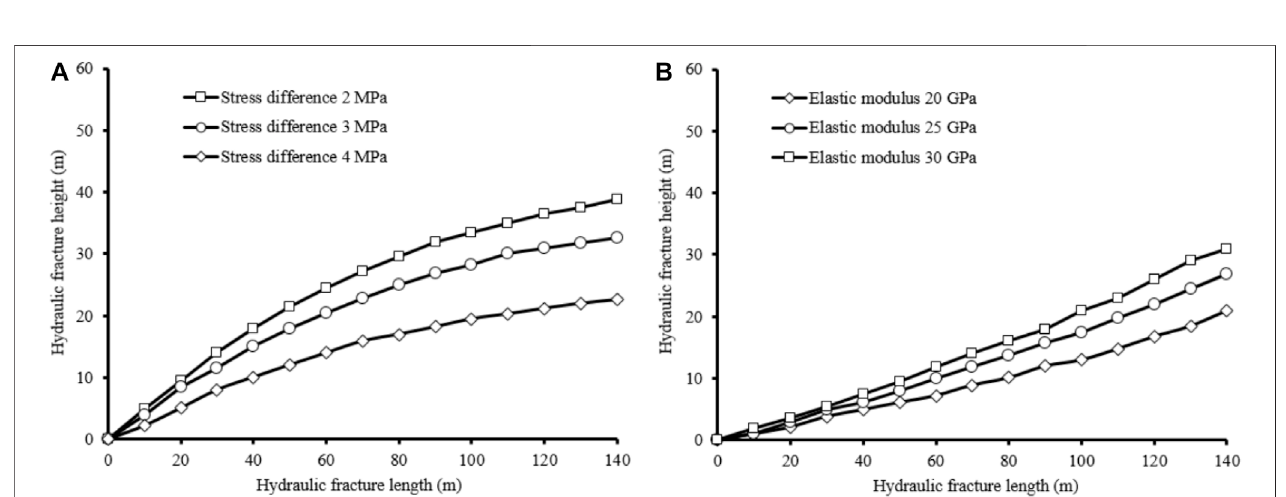
FIGURE 11 | In fl uence of in-situ stress and elastic modulus on hydraulic fracture height. (A) The in fl uence of the stress difference between the fracturing layer and the shielding layer on the hydraulic fracture height; (B) The in fl uence of the elastic modulus on the extension scale of the hydraulic fracture height.